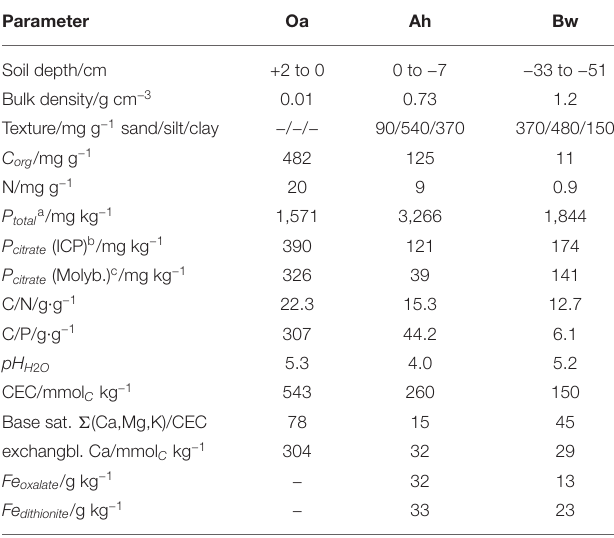
TABLE 1 | Characteristics of the sampled soil horizons (Lang et al., 2017).